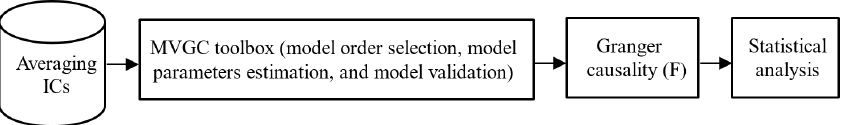
Figure 4. Work-flow of brain connectivity